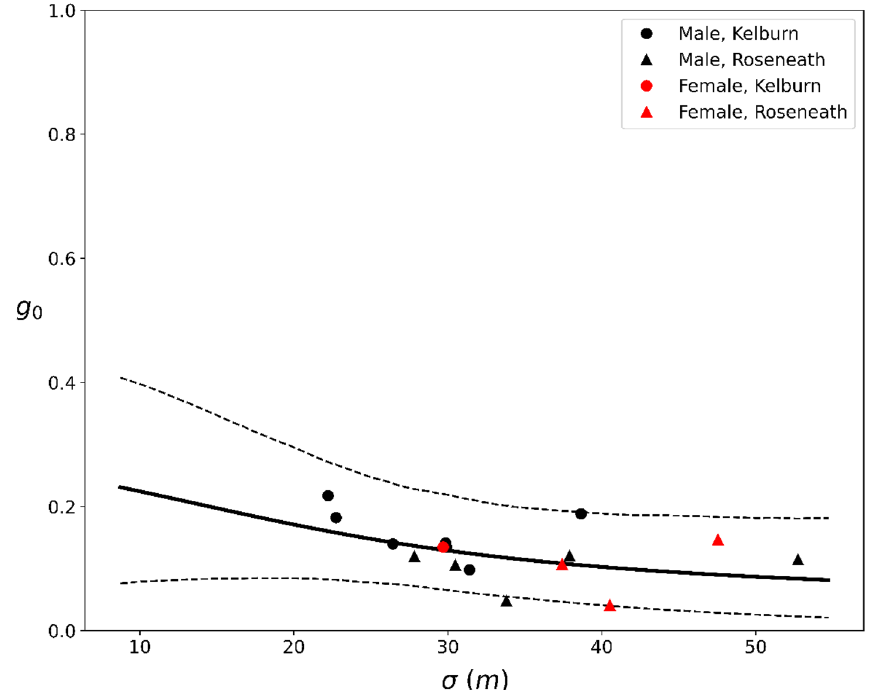
Figure 3. The predicted g 0 (the nightly probability of interaction given an encounter with a device located at the home range center) for 16 individual ship rats, Rattus rattus , as a function of the estimated σ (a spatial decay parameter that scales probability of detection to home range size). The solid line indicates the modelled mean, averaged across the three device types and individuals. The dashed lines indicate the 90% credible